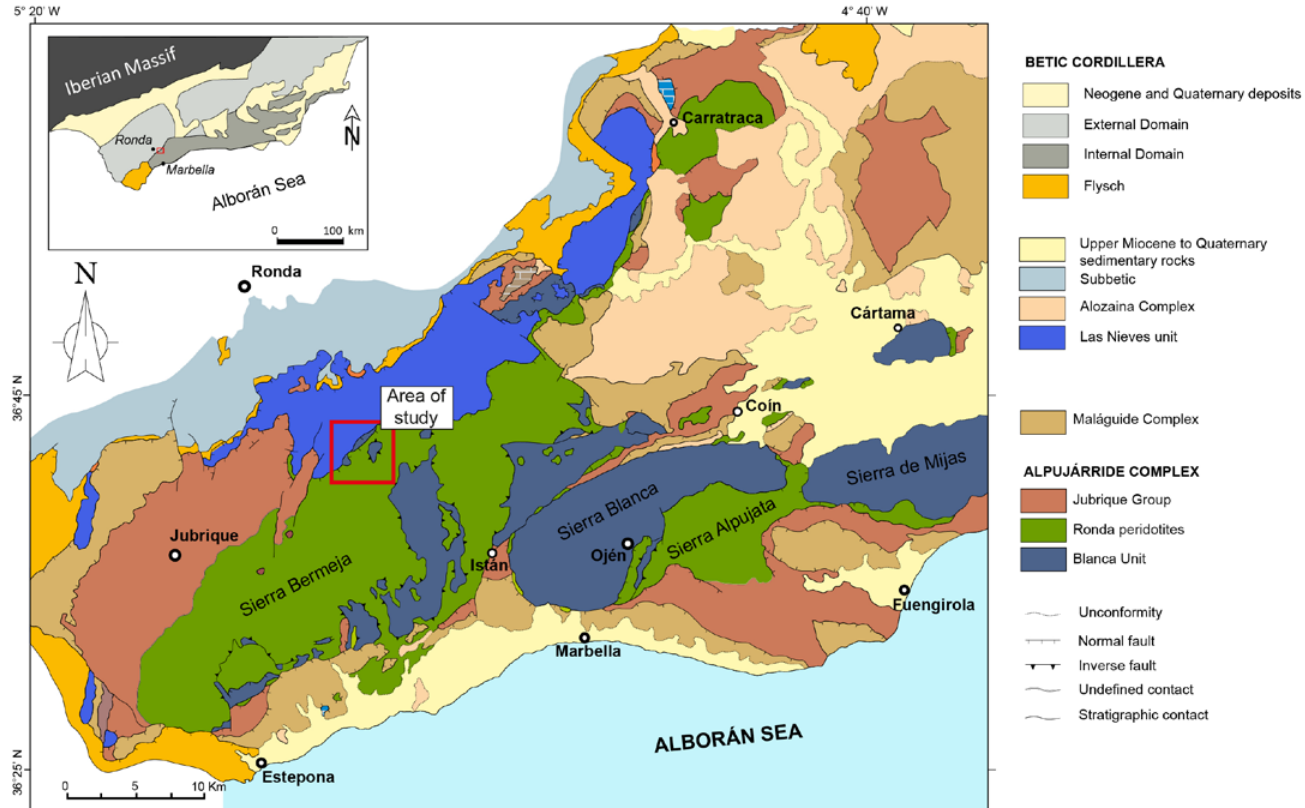
Figure 1. Geological map of the western Betic Cordillera, southern Spain showing the three main peridotite massifs cropping out in the Betic Cordillera: Ronda (~300 km 2 ), Ojén (~70 km 2 ), and Car- ratraca (~60 km 2 ). Modified from Gervilla et al. [15]. The red rectangle marks the localization of the El Robledal area. Inset: different domains of the Betic Cordilleras.